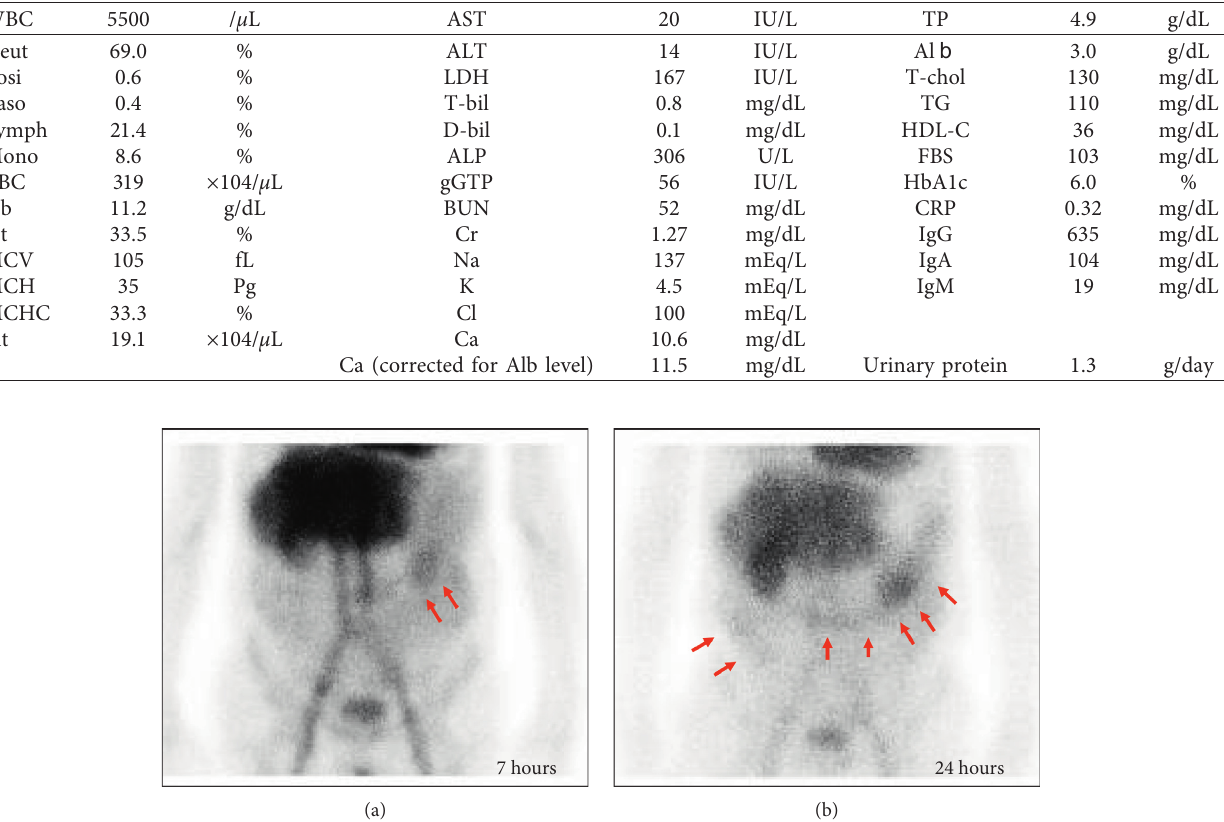
Figure 1: Scanning images of 99 mTc-labeled human serum albumin (HSA) scintigraphy. 99 mTc-labeled HSA scintigraphy revealed albumin leakage from the gastrointestinal tract (arrows). (a) At 7 hours of scanning, collection of the radiotracer was found in the left upper portion of the abdomen, indicating albumin loss into the small intestine. (b) At 24 hours of scanning, diffuse collection of the radiotracer was found in the right and upper portions of the abdomen, indicating albumin loss into the